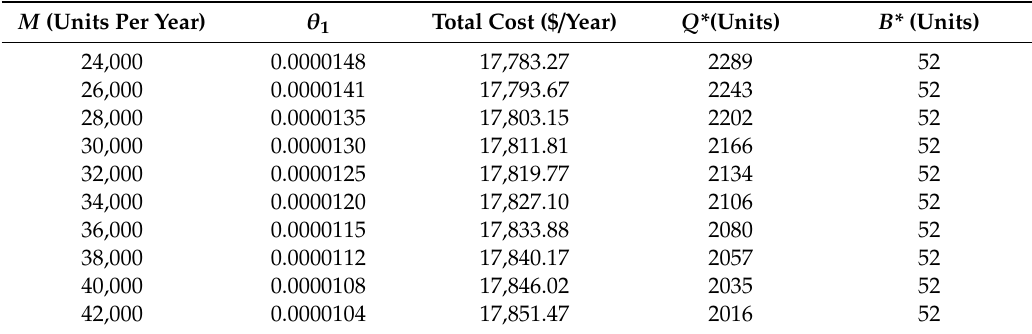
Figure 2. Change in optimal lot size with change in the inspection rate. Table 4. Change in optimal lot size and backorder quantity with variation in the inspection rate (Example 2).